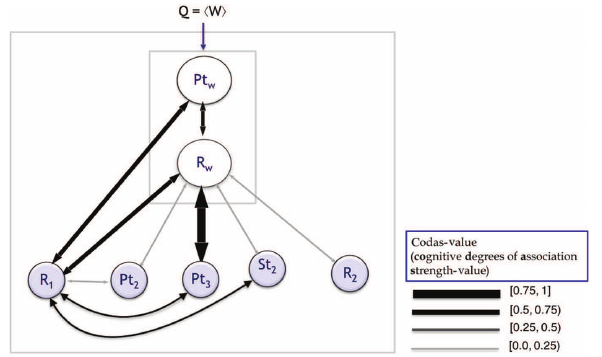
Figure 3: A Local Associative Subnetwork for a Query Consisting of One Word Query Term, i.e. Q = ⟨ W ⟩ . The query is headed by the instance pattern ⟨ Pt W ⟩ and the root instance ⟨ R W ⟩ . The instances ⟨ R 1 ⟩ and ⟨ Pt 3 ⟩ represent a possible contextual one-term query candidate for the word W . The degree of association strength is depicted by intervals for